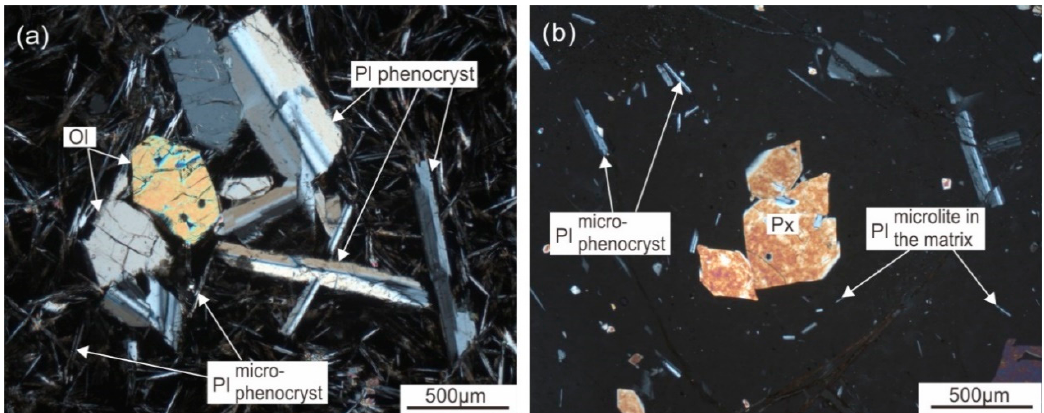
Figure 3. Representative photomicrographs of the SMAR basalt samples. ( a ) Olivine and plagioclase. Plagioclase generally occurs in three crystal sizes that include phenocryst, microphenocryst, and microlite in the matrix. ( b ) Pyroxene phenocryst. Ol: olivine; Pl: plagioclase; Px: pyroxene.